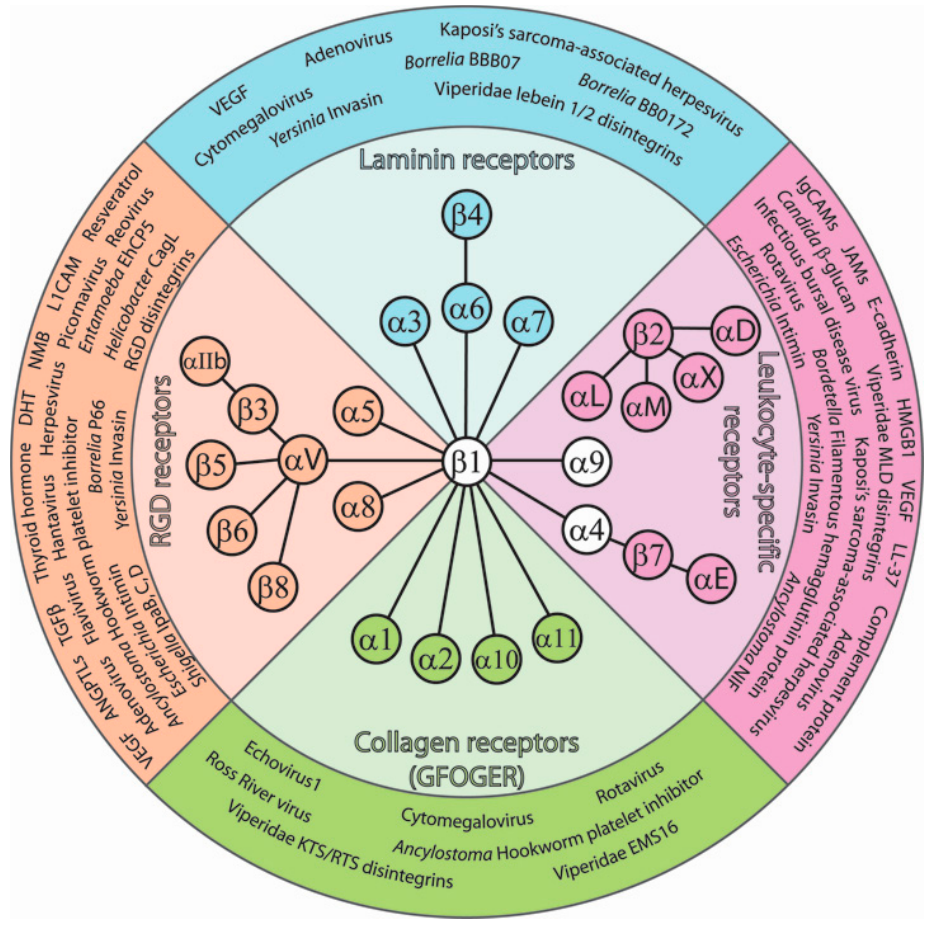
Figure 1. Integrin heterodimers and their ligands. Integrins are heterodimeric cell surface receptors that bind extracellular matrix (ECM) molecules. In addition to this role, integrins also bind many non-ECM ligands. Integrin subunits connected by a ray represent heterodimeric α / β binding partners. The inner ring depicts integrin heterodimers grouped into families based upon their classical binding profile. These families include RGD receptors, collagen (GFOGER) receptors, laminin receptors, or leukocyte-specific receptors. Within the outer ring, the non-ECM ligands of these families are listed. Non-ECM ligands include growth factors, hormones, venomous compounds, disintegrins, bacterial proteins, fungal polysaccharides, viruses, polyphenols, and counterreceptors.